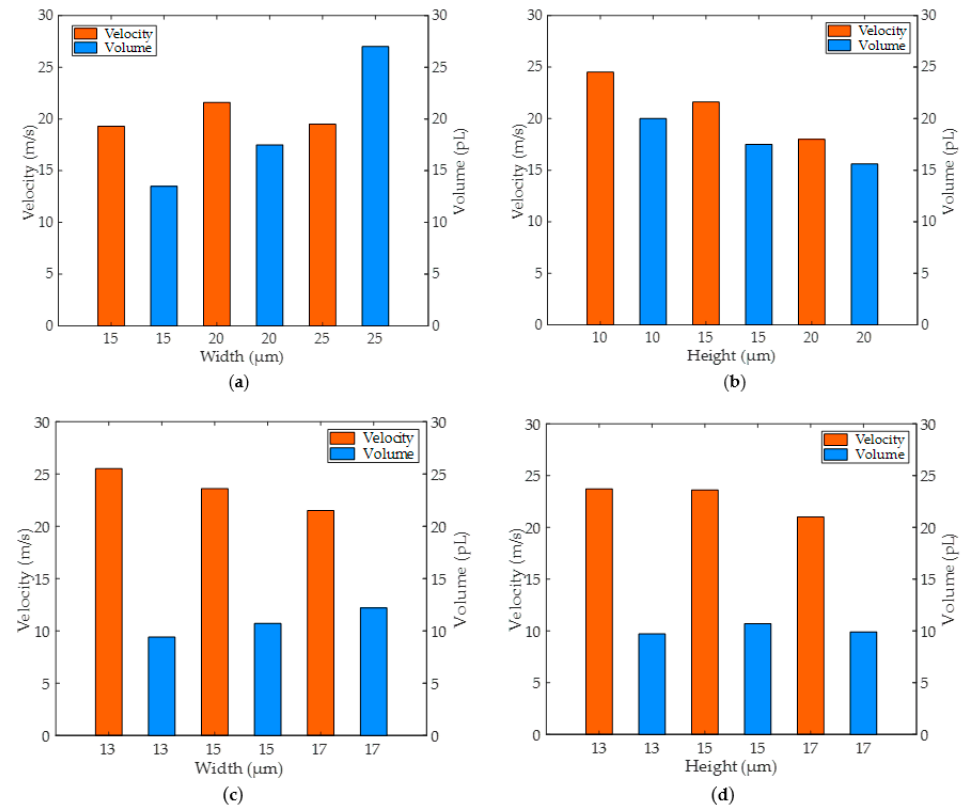
Figure 9. The liquid column’s maximum velocity and the droplet’s volume change for straight and conical shrinkage nozzles. ( a ) Under the different widths of the straight nozzles, the liquid column’s velocity and the droplet’s volume change; ( b ) Under the different heights of the straight nozzles, the liquid column’s velocity and the droplet’s volume change; ( c ) Under the different widths of the conical shrinkage nozzles, the liquid column’s velocity and the droplet’s volume change; ( d ) Under the different heights of the conical shrinkage nozzles, the liquid column’s velocity and the droplet’s volume